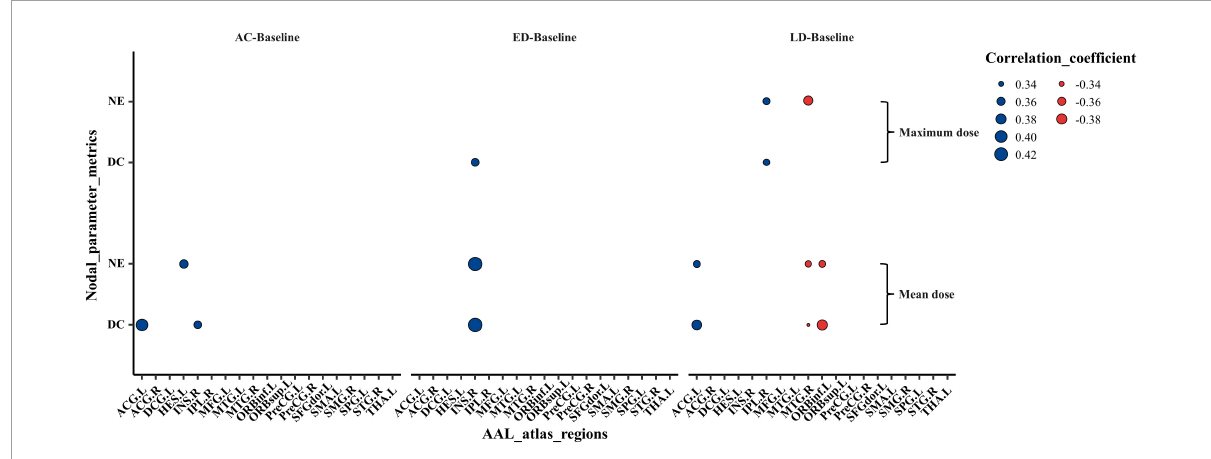
FIGURE5 The Spearman’s correlations between the abnormal nodal metrics (NE and DC) and the mean as well as maximum irradiation dose of ipsilateral temporal lobe. The Spearman’s rank correlation coefficients ( r -value) at the significance level of p < 0.05 were shown. The size of dots indicated the strength of the correlations and the color of dots indicated the orientation of the correlations (Blue: positive correlation, Red: negative correlation). NE, nodal efficiency; DC, degree centrality; AC, post-RT-AC; ED, post-RT-ED; LD,